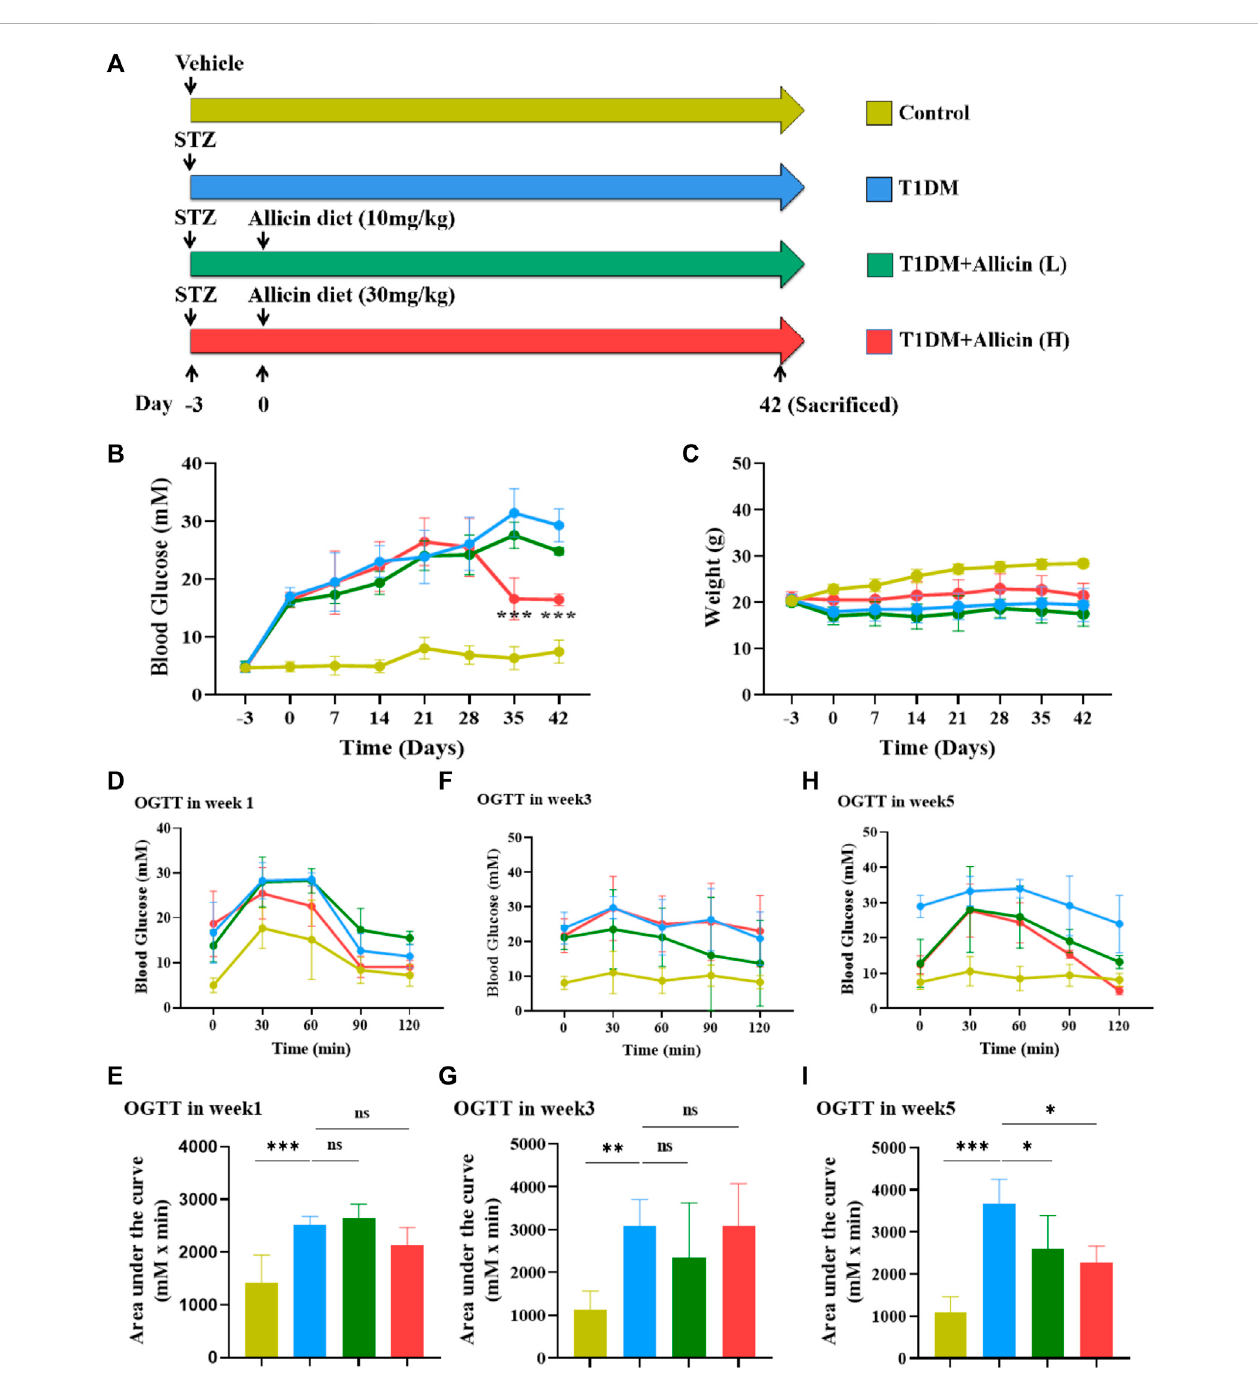
FIGURE 1 TheeffectsofAllicinonbloodglucoselevelsandglucosetoleranceinT1DMmice. (A) Theschematicdiagramdepictstheprogressofanimalexperiments with allicin in STZ-induced T1DM mice. Different colors indicate different treatments for mice. (B) The fasting blood glucose levels of mice in each group at different time points. (C) The body weight of mice in each group at different time points. (D) The curve graph of oral glucose tolerance test (OGTT) from 0 to 120 minatweek1. (E) ThequantitativeresultsofOGTTatweek1. (F) ThecurvegraphofOGTTfrom0to120 minatweek3. (G) Thequantitativeresultsof OGTTatweek3. (H) ThecurvegraphofOGTTfrom0to120 minatweek5. (I) ThequantitativeresultsofOGTTatweek5. N =3,Mean±SD. *p < .05, **p < .01, ***p < .001 indicate signi fi cant differences, and ns > .05 means no signi fi cance